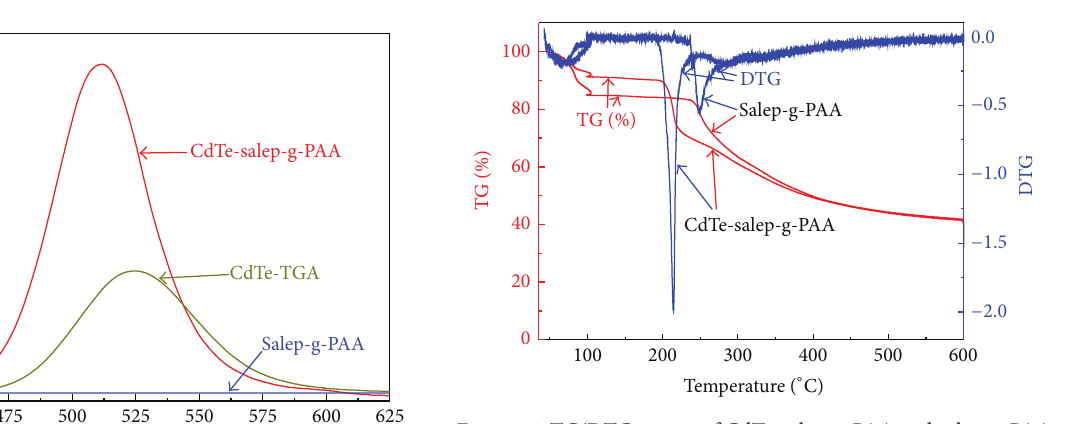
Figure 4: TG/DTG curves of CdTe-salep-g-PAA and